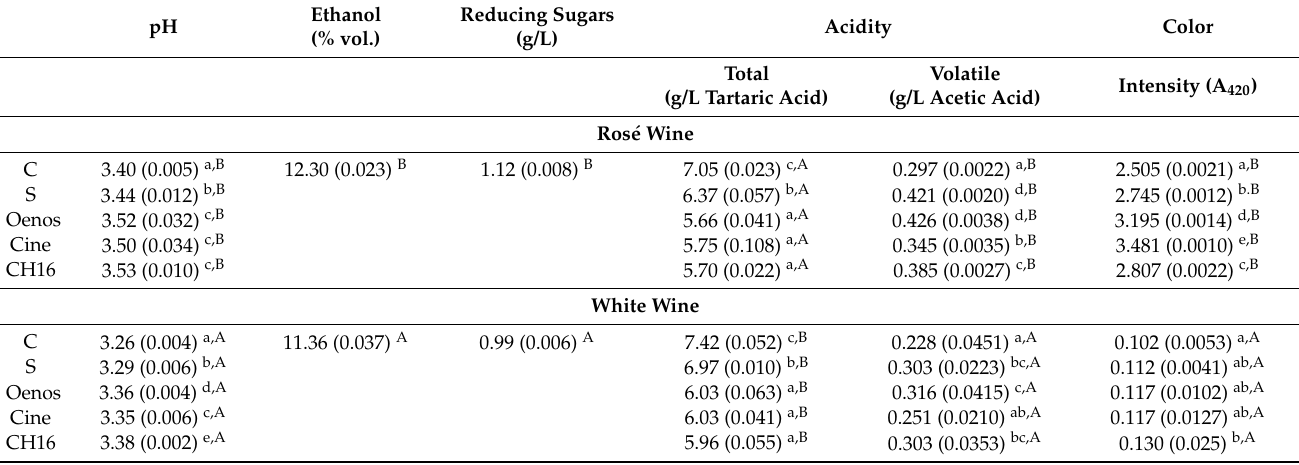
Table 1. Standard enological parameters at the end of alcoholic and malolactic